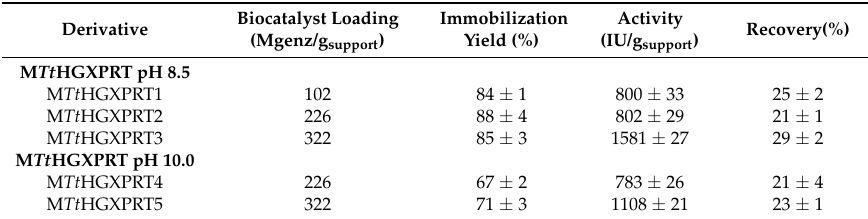
Table 1. Effect of enzyme/support mass ratio on the immobilization of Tt HGXPRT on MagReSyn ® aldehyde microspheres. M Tt HGXPRT: MagReSyn ® Amine magnetic iron oxide porous microparticles of hypoxanthine–guanine–xanthine phosphoribosyltransferase. Biocatalyst Loading Immobilization Activity Derivative (Mgenz/g support ) Yield (%) (IU/g support )